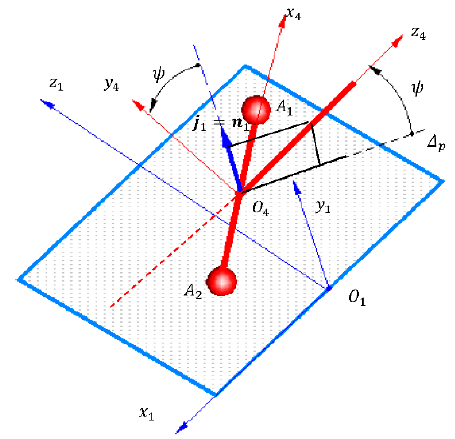
Figure 14. Simple displacements from the bipod joint.